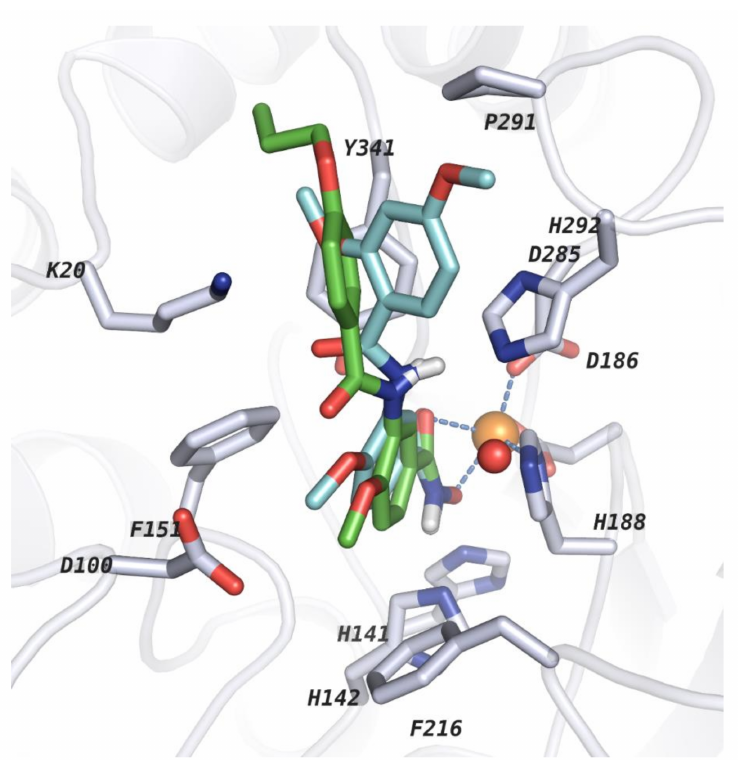
Figure 11. Comparison of the topped docking pose for the poorly predicted molecule (compound 14 ; cyan) with a closely related molecule (compound 12 ; green). Protein backbone is shown as ribbon and side chains of key amino acid residues in the active sites are shown as white sticks. Catalytic zinc ion and conserved water molecule are shown as orange and red spheres,